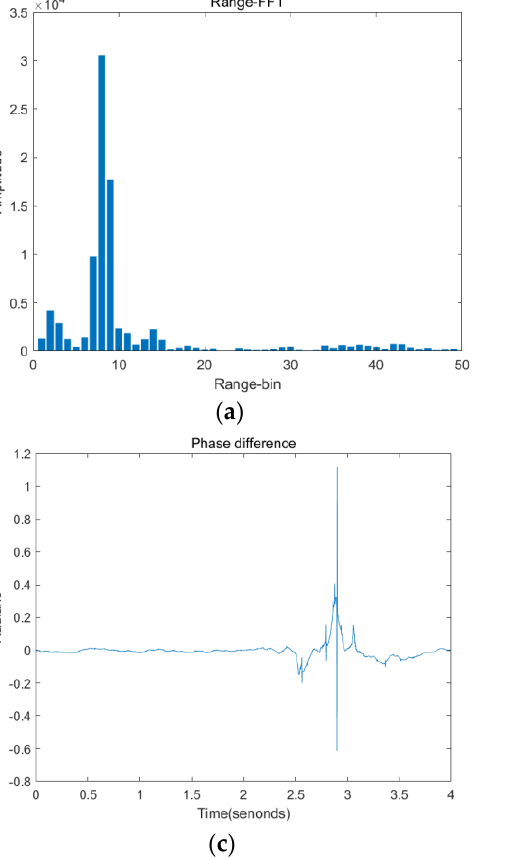
Figure 3. Signal processing: ( a ) Rang − FFT; ( b ) phase; ( c ) phase difference; ( d ) vibration signal.